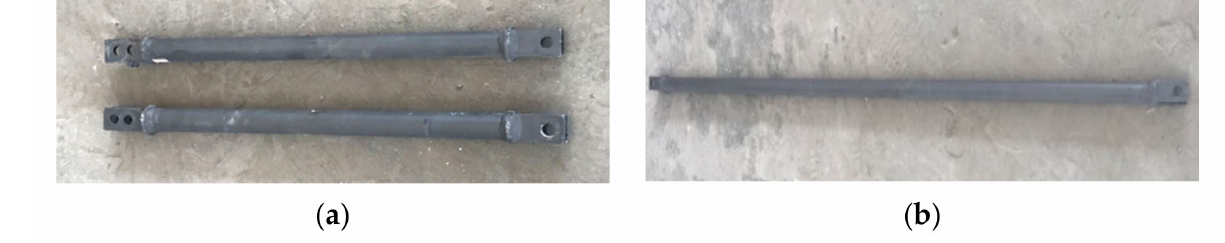
Figure 6. Photographs of the HBs. ( a ) HB-3; ( b ) HB-1/HB-2.